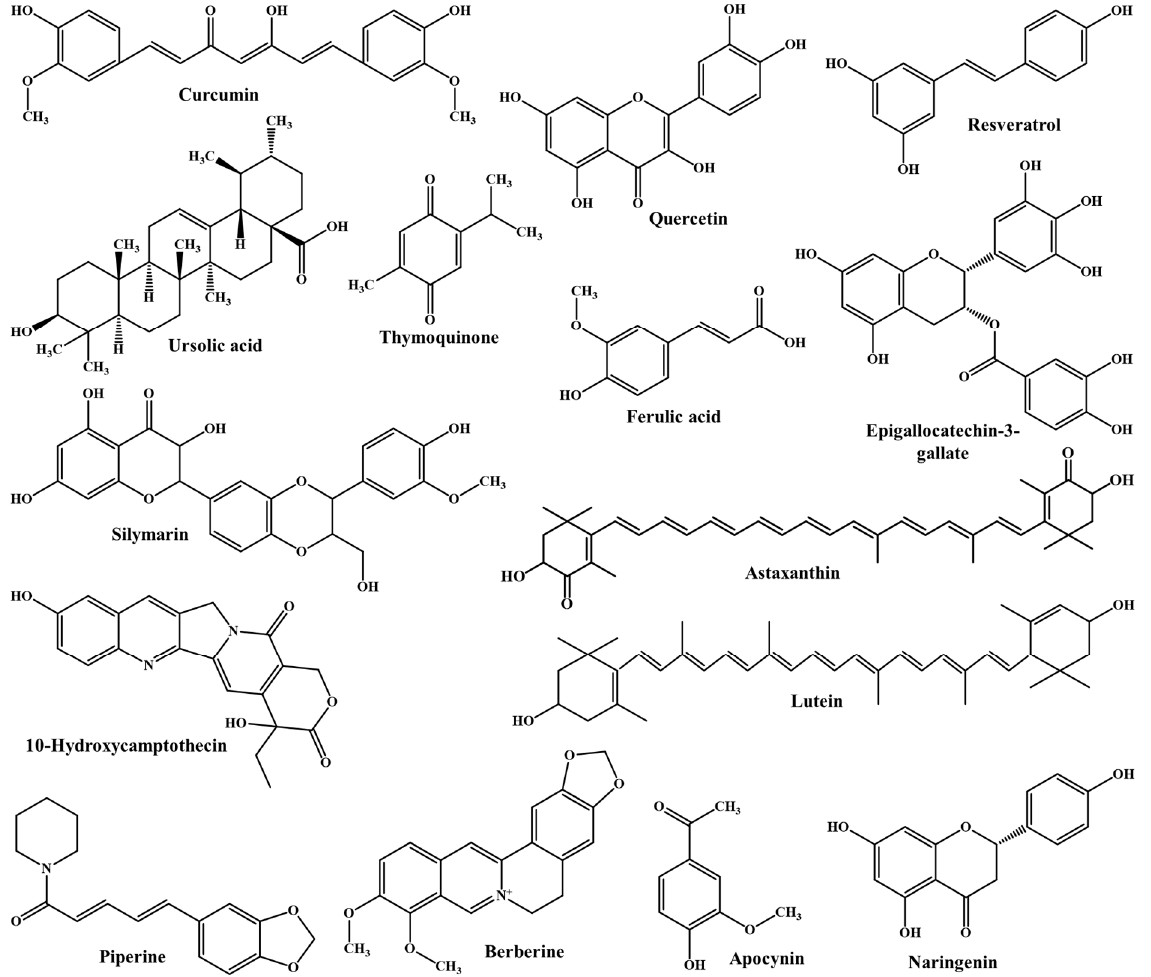
Figure 1. Chemical structures of selected phytochemicals reviewed in this manuscript for oral bioavailability and bioactivity after encapsulation in CS-NPs .